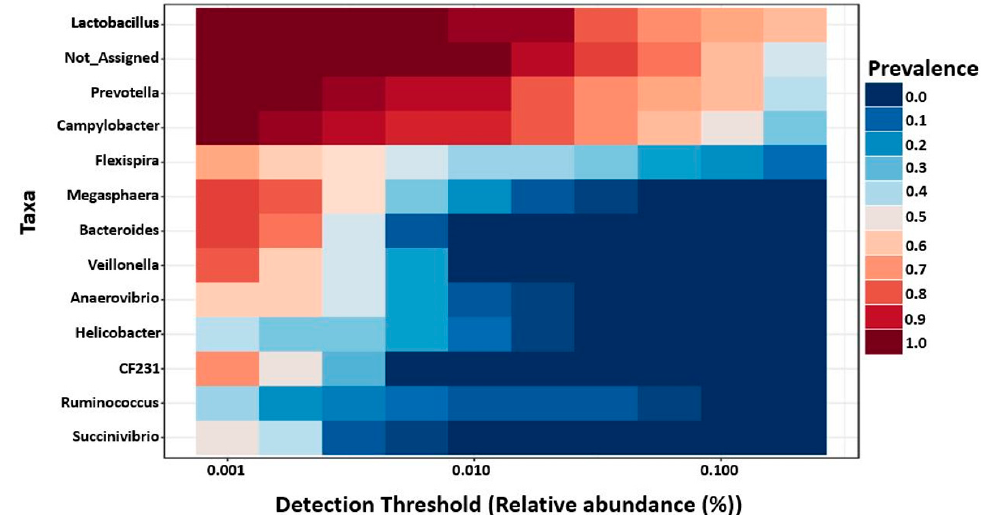
Figure 5. Core bacterial genera in 7-day post-weaned pigs as identified by MicrobiomeAnalyst using the parameters sample prevalence (20%) and relative abundance (0.2%). Not_Assigned represents the sequence reads that were not assigned at the genus level but assigned at the higher taxonomic level.